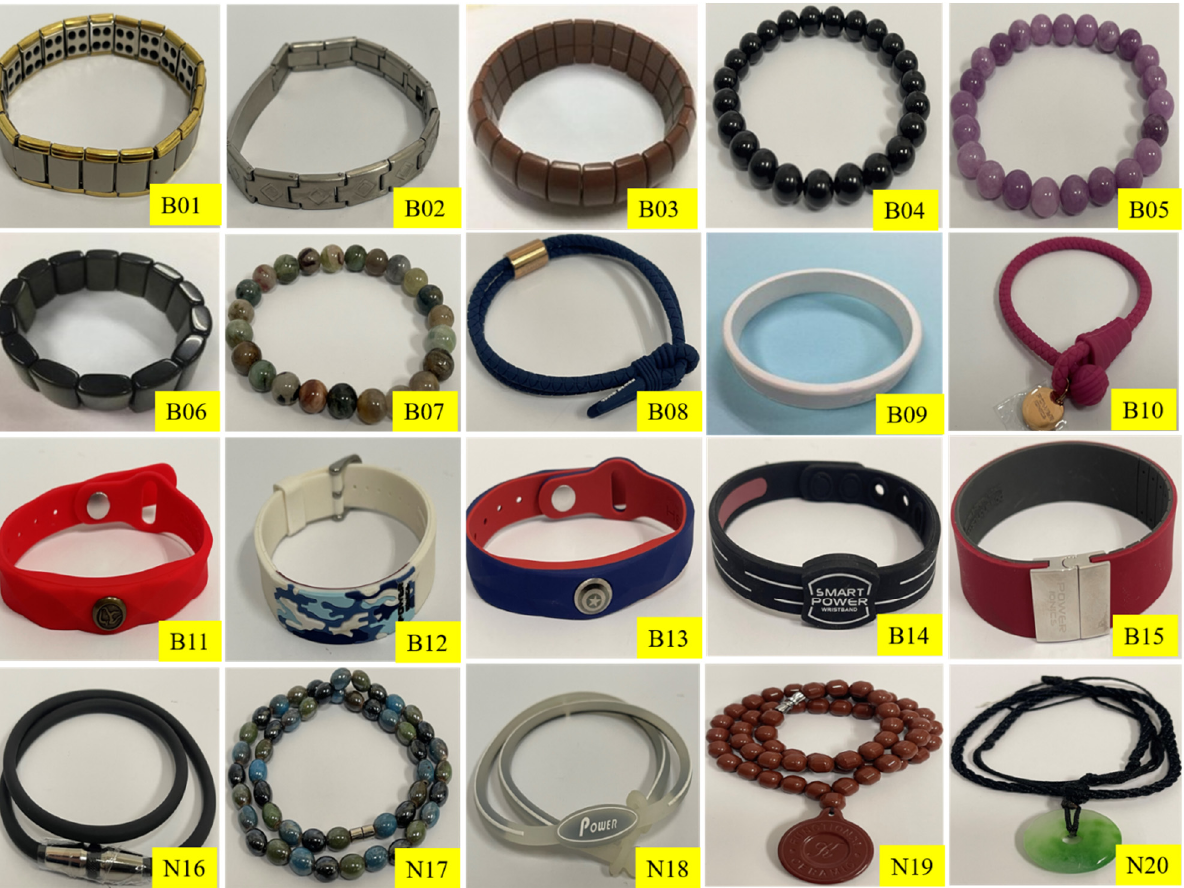
Figure 1. Bracelet and necklace samples.